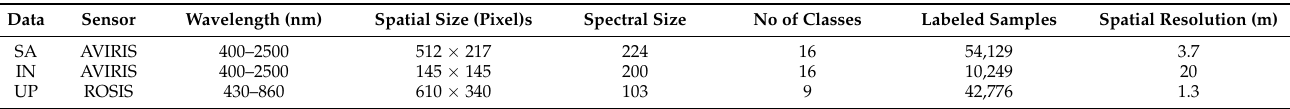
Table 1. Datasets employed during